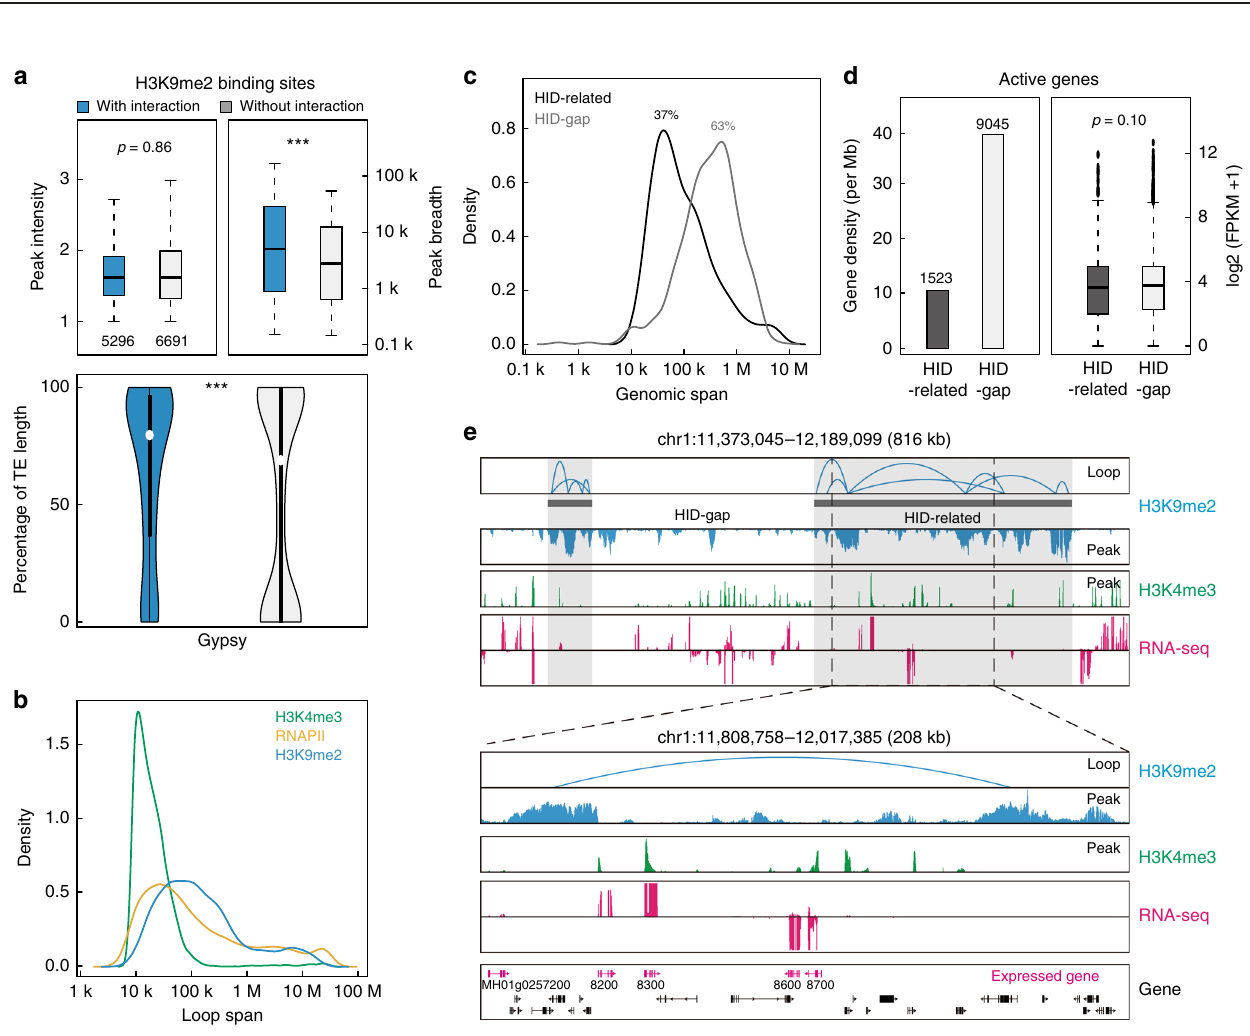
Fig. 3 Identi fi cation of Heterochromatin-related chromatin interacting domains. a Boxplots for peak intensity (upper left), peak breadth (upper right), and transposable element (TE) occupancy (bottom panel) of H3K9me2-binding sites involved and not involved in interactions. *** p < 0.001 from Wilcoxon test. b Loop span distribution of interactions mediated by H3K9me2 (5627), H3K4me3 (9714), and RNAPII (17160). c Genome span distribution of HID- related and HID-gap regions. The percentages of their genome occupancy are shown above. d Density and transcriptional level of active genes (marked by H3K4me3 anchors) located in HID-related and HID-gap regions. p = 0.10 from Wilcoxon test. e Representative screenshot for one H3K9me2-related heterochromatic interacting domains (HID-related) showing H3K9me2 ChIA-PET data overlapped with H3K4me3 ChIP-Seq and RNA-seq data. There were a few H3K4me3 peaks and expressed genes in the HID-related segments with lower densities compared with those in HID-gap segments (the genomic regions excluding HID-related regions). A few expressed genes (magenta) marked by H3K4me3 were observed inside the H3K9me2 loop. Boxplots in a , d show the median, and third and fi rst quartiles. Source data of a , d are provided as a source data fi